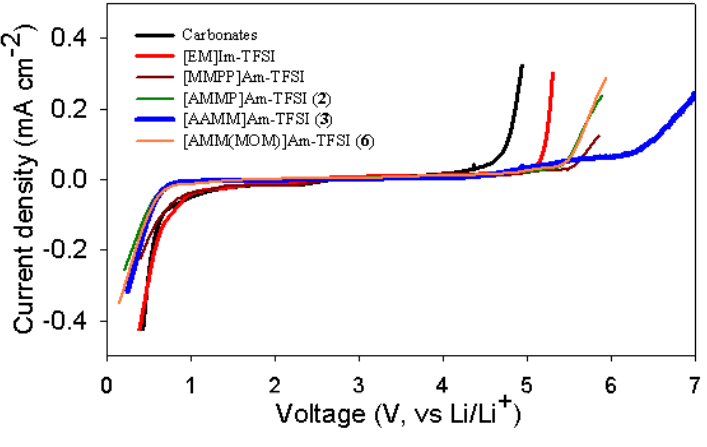
Figure 2. Electrochemical stability windows of the ILs with 1.0 M